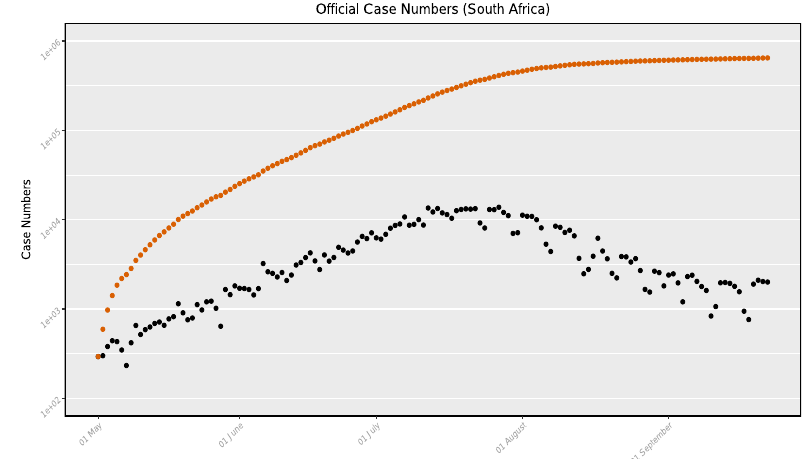
Fig. 11 Of fi cial case numbers for South Africa from 1 May to 20 September 2020. Orange points denote cumulative cases, black points refer to daily new infections. Note that the peak in new infections is located at the end of July and the beginning of August,